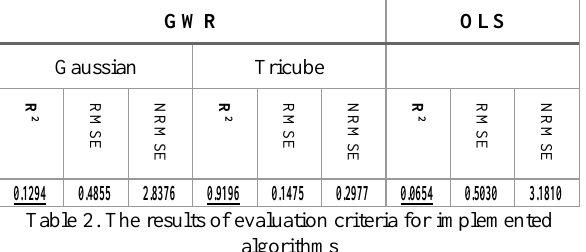
Figure5. Results of GWR with Gaussian kernel